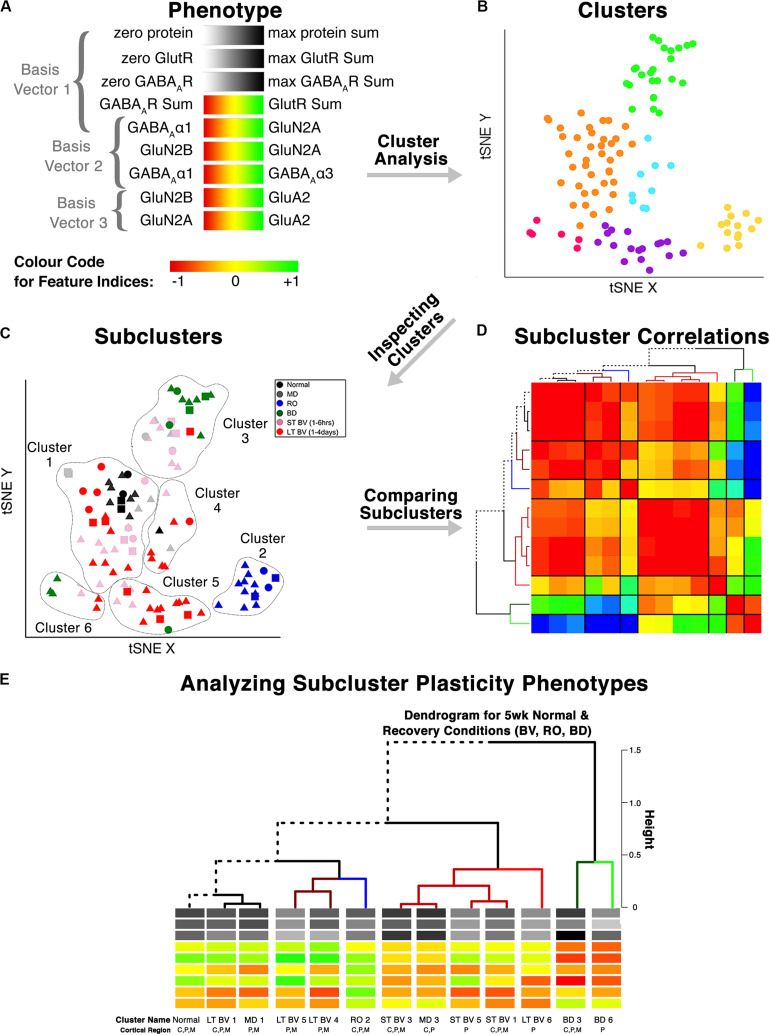
Analysis workflow to use plasticity phenotypes in cluster analysis. The analysis workflow is shown for using the plasticity phenotypes to identify clusters and subclusters [adapted from Balsor et al. (2019b), used with permission]. (A) The color-code for each of the nine plasticity features. The nine plasticity features were used as the input for the tSNE analysis, and k-means clustering was applied to the transformed data. (B) The tSNE identified clusters are color-coded. (C) The composition of the clusters was inspected by coding the rearing conditions using different colored symbols. (D) Samples from the same rearing condition and cluster are divided into subclusters, and the strength of the pairwise correlations among the plasticity phenotypes is shown using a correlation matrix. (E) The plasticity phenotypes for each subcluster were displayed at the ends of the dendrogram that ordered the subclusters (D).